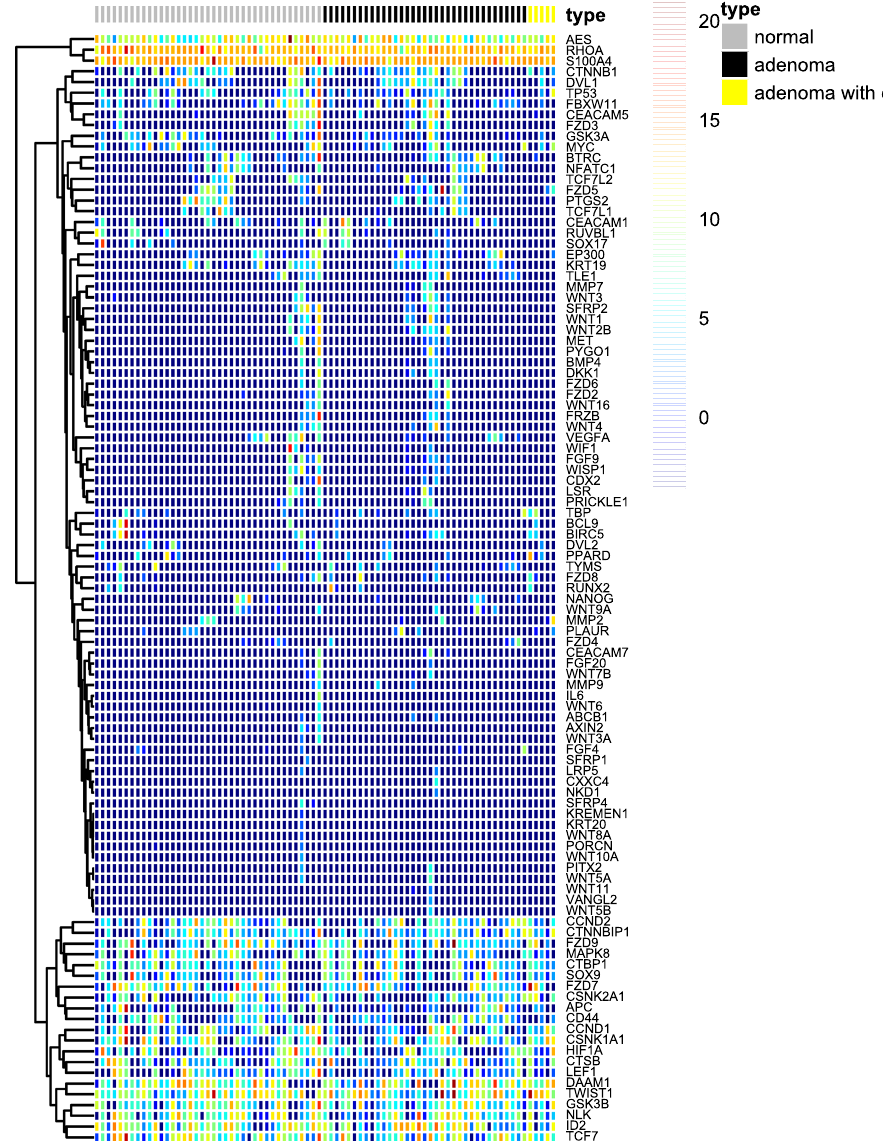
Figure 3. Hierarchical clustering of samples and gene expression in normal and colorectal adenoma. The hierarchical clustering of gene expressions in normal and colorectal adenoma plasma samples was achieved by complete linkage of Euclidean distance based on variance stabilizing transformed count data of 103 detectable genes in CRC-related mRNA